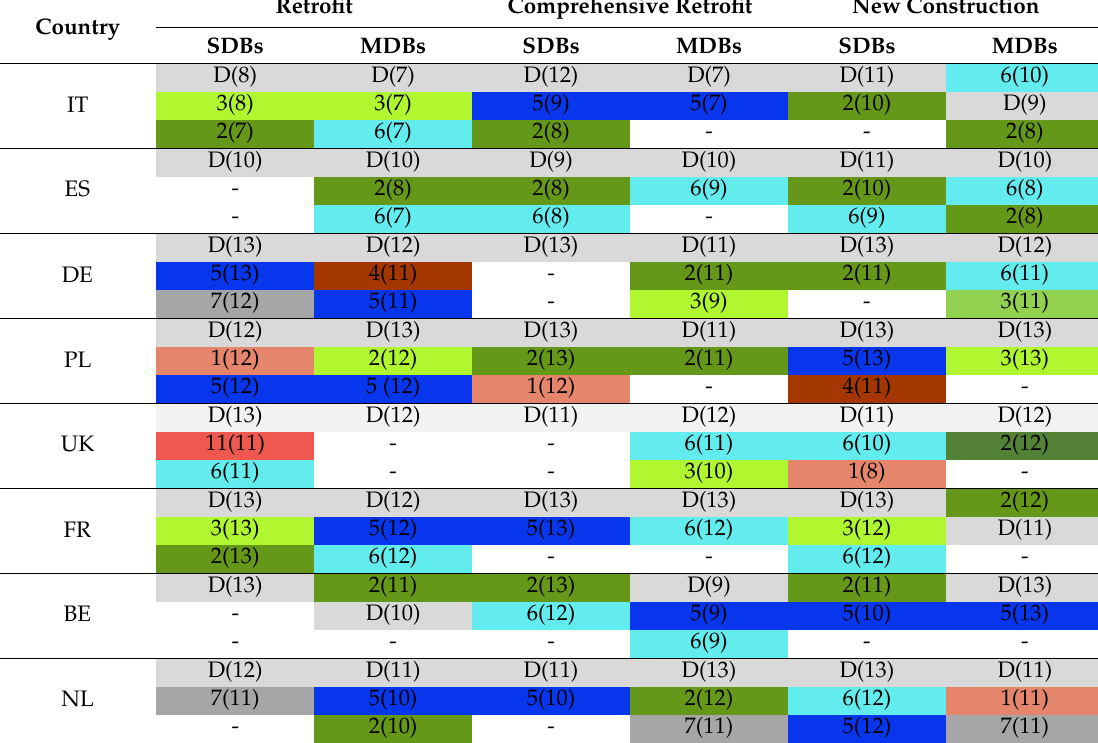
Table 13. Stakeholders with the highest number of streams of communication (sum of all links) in each case. Retrofit Comprehensive Retrofit New Country